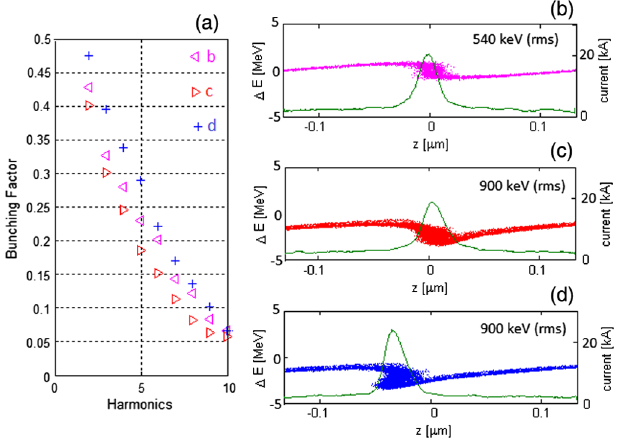
FIG. 2. Simulation of the longitudinal phase space distribution of a 266 nm wavelength seeded microbunch before (b) and after (c) velocity bunching in a 15 m beamline with an average beam radius of 175 μ m (rms), a beam energy of 700 MeV, 5 kA initial peak current, and an initial uncorrelated energy spread of 100 keV (rms). Grey arrows indicate the direction of energy changes associated with Coulomb forces. After the drift, a longitudinal dispersion of 15 μ m was used to do the final bunching. In (d), the microbunch from (c) has experienced an additional 10 μ m of dispersion. The final slice energy spread is less than in Fig. 1 and the average energy is the same as that of the neighboring